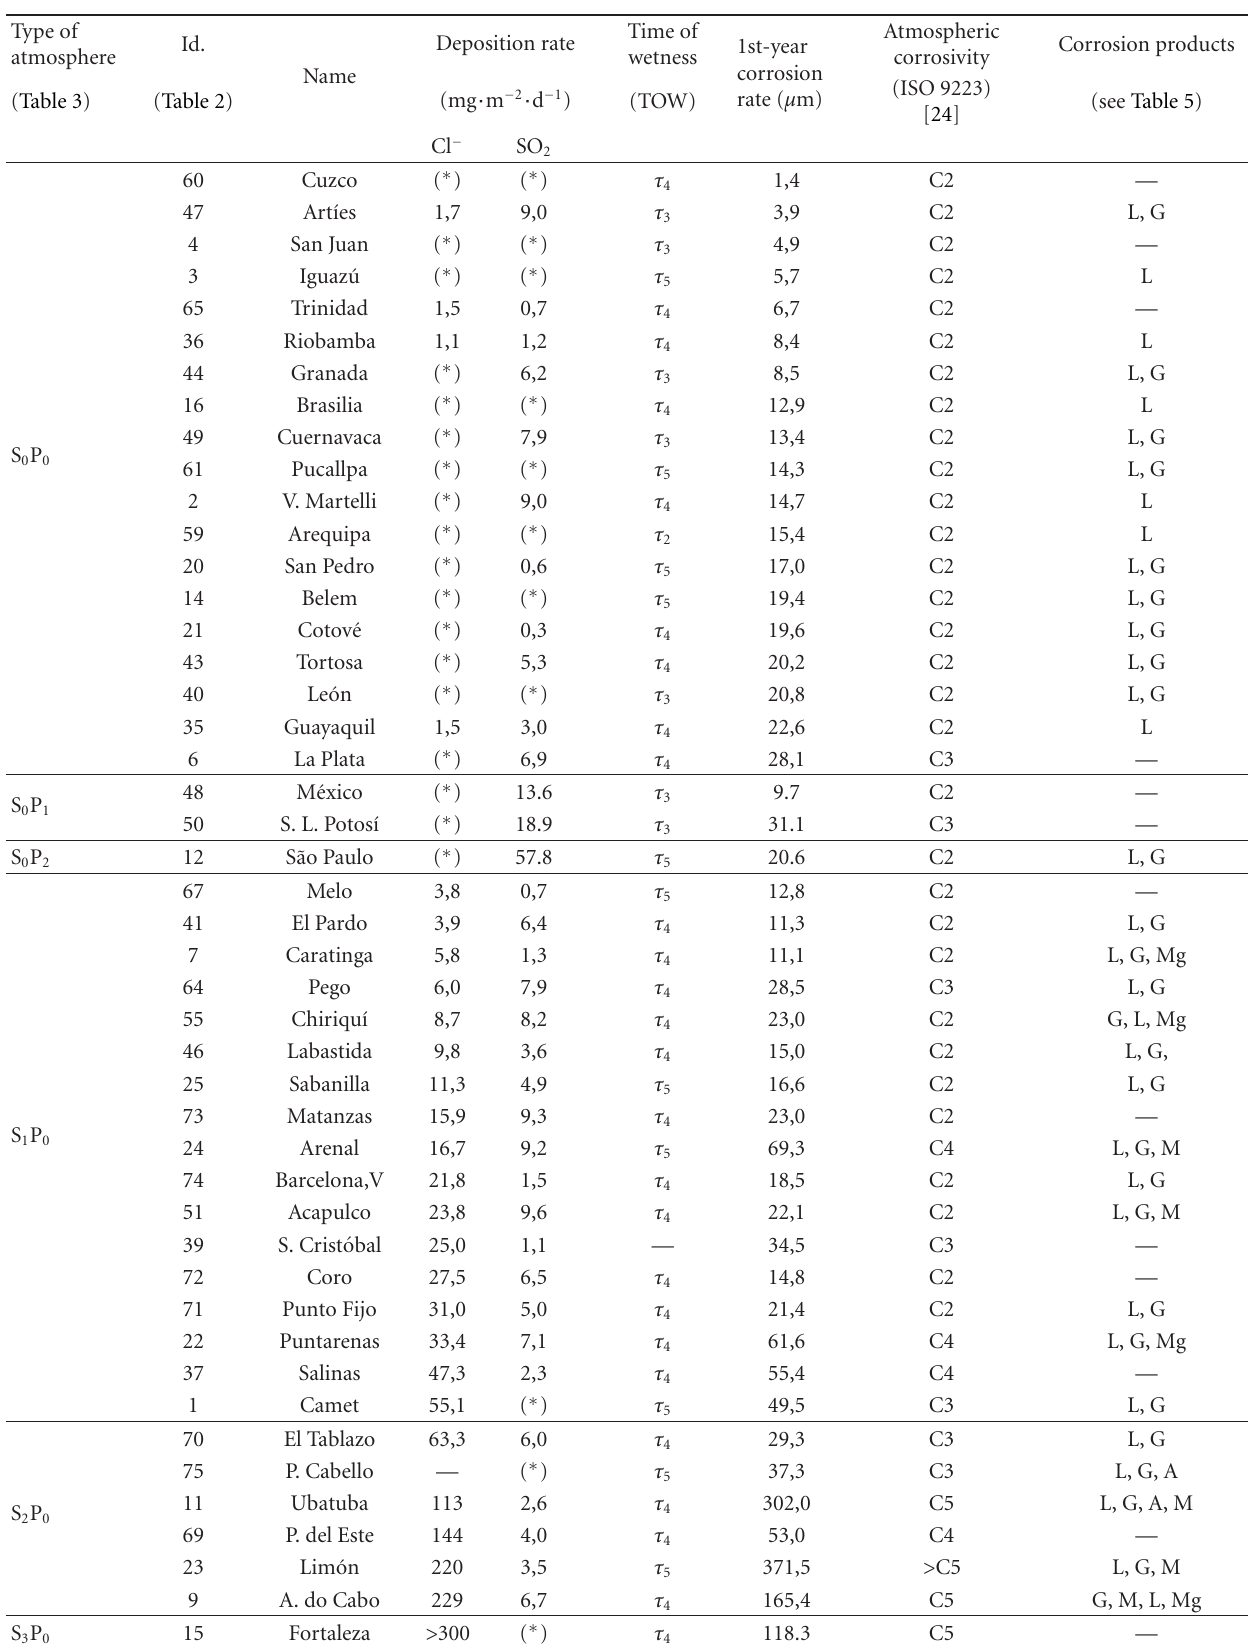
Table 4: MICAT test sites characteristics. Data for mild